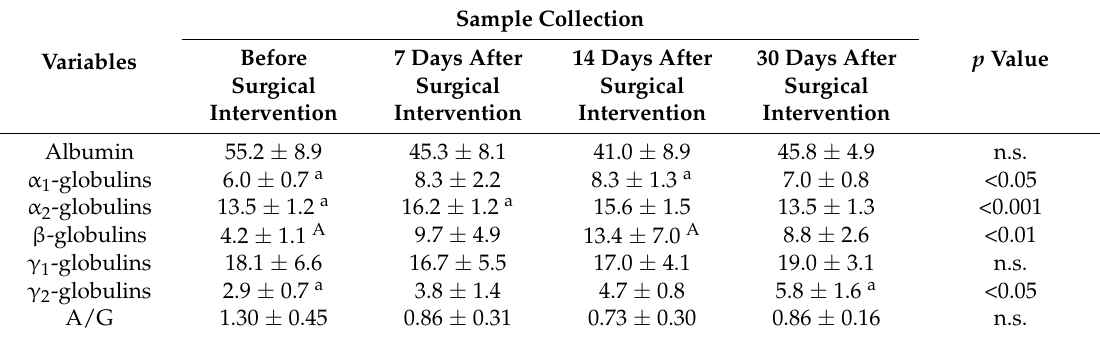
Table 1. Changes in the relative concentrations of serum protein fractions (%) and albumin/globulin ratio (A/G) in sheep before surgical intervention and in the postoperative period (mean ± SD).